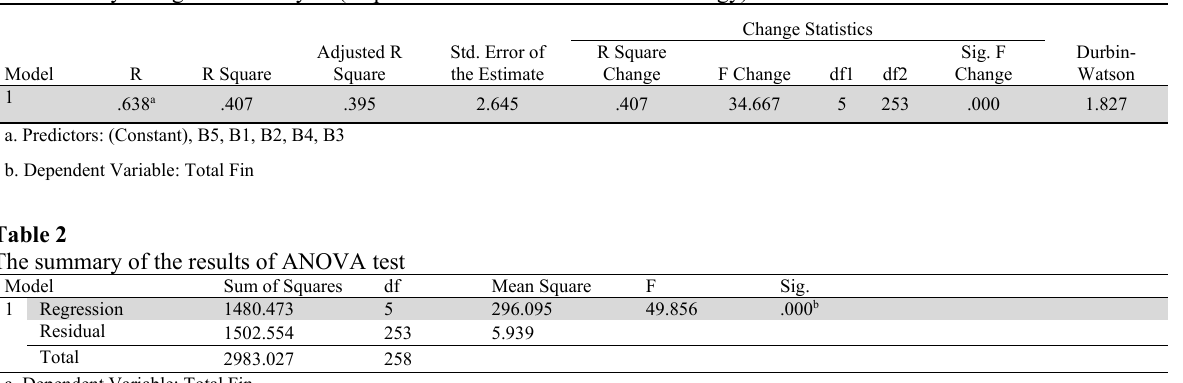
The summary of regression analysis (Dependent variable: Financial technology)